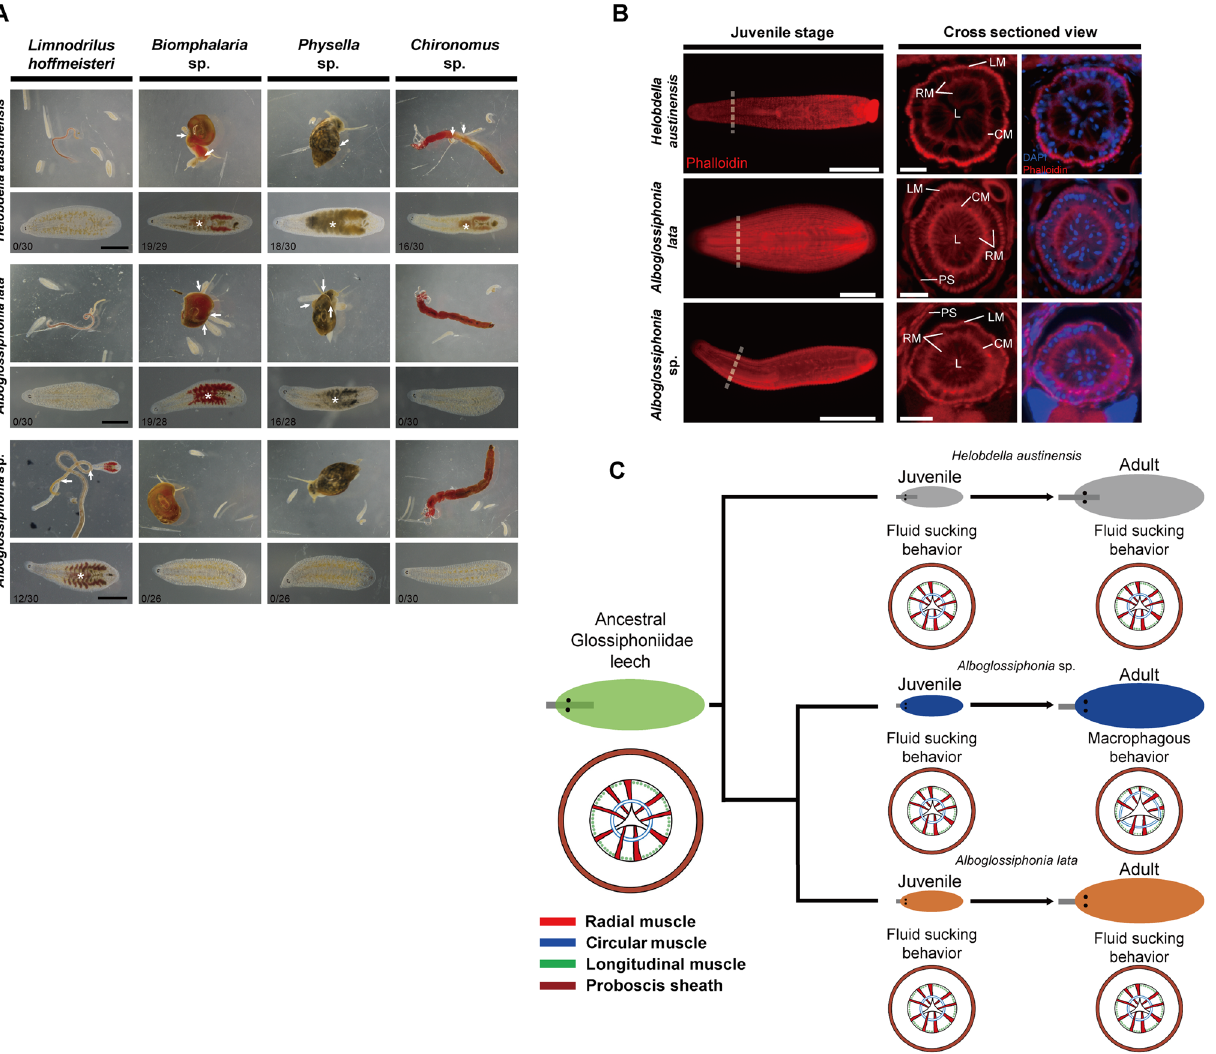
Figure 5. Juveniles of Alboglossiphonia sp. show fluid-sucking behavior and well-developed muscular structures. ( A ) Selective prey preferences among the juvenile stages of leeches. Four different prey organisms were introduced to the juvenile stages of three leech species. White arrows show the locations at which leeches fed on different species of prey. The juvenile stage of Alboglossiphonia sp. has the same ingestion behavior as H. austinensis and A. lata . Asterisks indicate contents in the intestine 48 h after the start of test. The numbers on the bottom left indicate the number of juveniles with filled guts compared to the total number. See Supplementary Movie 5 for ingestion behavior of Alboglossiphonia sp. Scale bars 500 μm. ( B ) A comparison of proboscis musculature in the juvenile stage indicates that three species have well-developed and partitioned radial muscles, as well as circular muscles in the proboscis. F-actin (red, phalloidin) and nuclei (blue, DAPI) were stained to confirm the morphology and muscle arrangement of the proboscis within juvenile leeches. White dashed lines in the first column indicate the sectioned region. CM, circular muscle; L, lumen; LM, longitudinal muscle; PC, proboscis cavity; PS, proboscis sheath; RM, radial muscle. Left column scale bars 500 μm; middle columns scale bars 20 μm. ( C ) Schematic of divergent proboscis structure according to prey preference in glossiphoniid leeches. The results of this study show that juveniles have conserved ingestion behavior and proboscis muscular structure. From a putative ancestral mechanism of feeding in glossiphoniid leeches, differences in prey preference may have influenced speciation events, and with them, changes in the morphology associated with feeding behavior. Thus far, observations suggest a conserved pattern in fluid- sucking ingestion among glossiphoniid juveniles, and at least one case of divergence to macrophagous feeding in the adult form of Alboglossiphonia